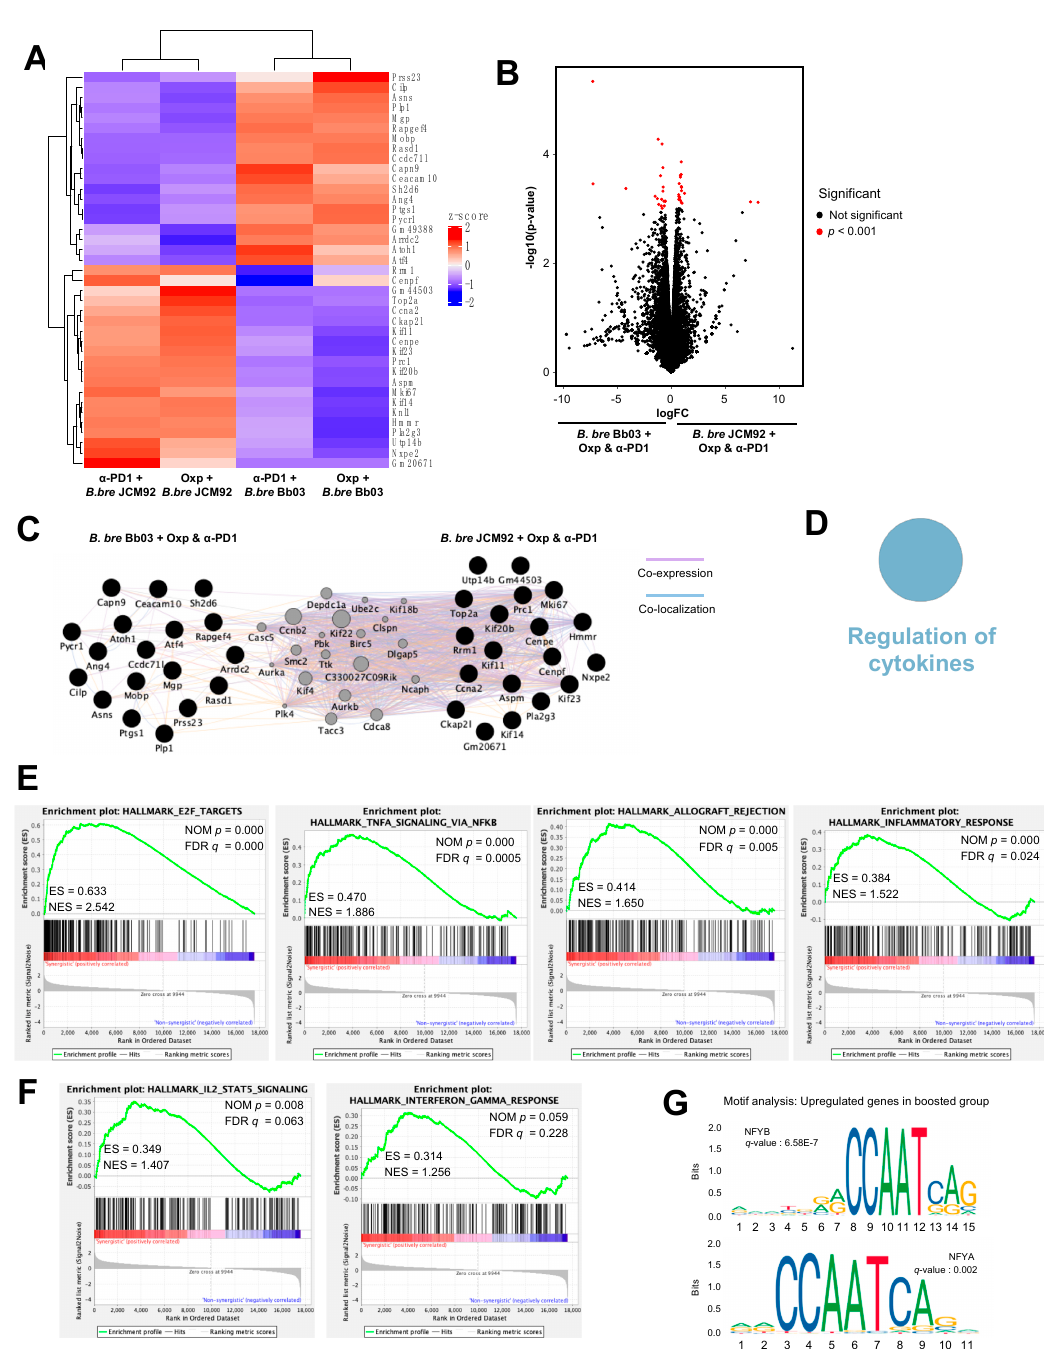
Figure 6. Effect of cancer therapeutics and B. breve strains on the intestinal transcriptome. ( A ) Heat map showing hierarchical clustering of differentially expressed genes (DEGs) between mice treated with cancer therapeutics (oxaliplatin or PD-1 blockade) and B. bre JCM92 or B. bre Bb03. ( B ) Volcano plots illustrating genes between mice treated with cancer therapeutics and B. bre JCM92 and mice treated with cancer therapeutics and B. bre Bb03. Red dots represent significantly different genes ( p < 0.001). ( C ) Network analysis of DEGs from mice treated with cancer therapeutics and B. bre JCM92, and mice treated with cancer therapeutics and B. bre Bb03 using Cytoscape. Co-expressed and co-localized genes are indicated by purple and blue lines, respectively. ( D ) Representation of the ClueGO functional network analysis shows upregulated genes in mice treated with cancer therapeutics and B. bre JCM92 compared to mice treated with cancer therapeutics and B. bre Bb03. ( E , F ) GSEA of intestinal transcriptome data exhibited that mice treated with cancer therapeutics and B. bre JCM92 were significantly enriched in hallmark pathways compared to mice treated with cancer therapeutics and B. bre Bb03. ( G ) Motifs within upregulated genes of mice treated with cancer therapeutics and B. bre JCM92. NFYB, nuclear transcription factor Y subunit beta; NFYA, nuclear transcription factor Y subunit